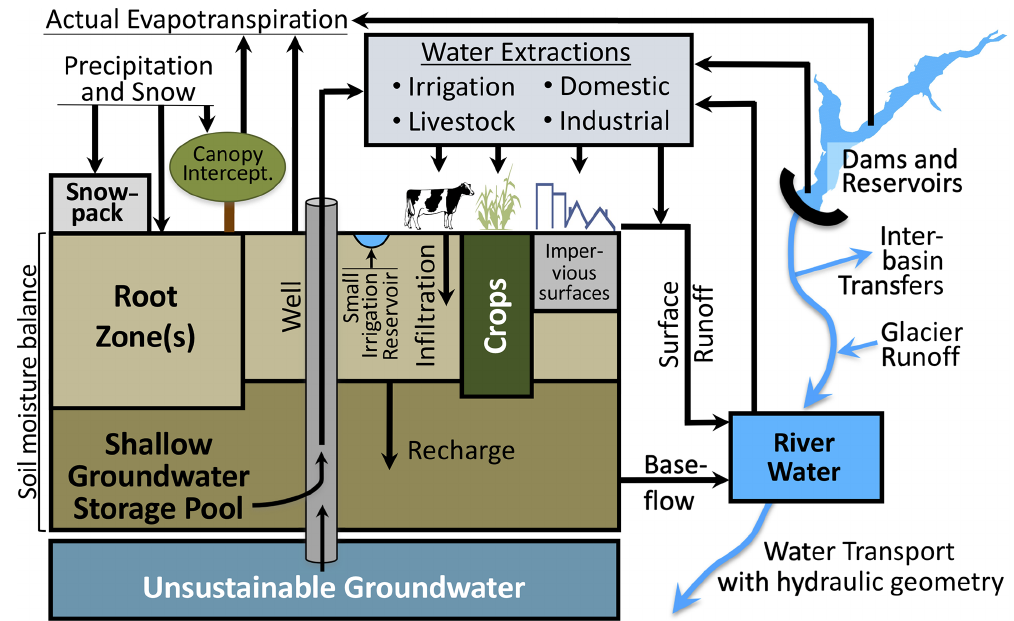
Figure 1. Schematic representation of the water balance model (WBM) showing major fluxes and storages, which are described in Sect. 2.2.1–2.2.6 below. The land surface fluxes are described in Sect. 2.2.1, and are: precipitation and snow, canopy interception, open water, runoff from impervious surfaces, soil moisture balance, actual evapotranspiration, surface runoff, and glacier runoff. Both the shallow groundwater storage pool and the unsustainable groundwater are described in Sect. 2.2.2. River water, including baseflow and hydraulic geometry, is described in Sect. 2.2.3. Section 2.2.4 describes dams and reservoirs, inter-basin transfers, and small irrigation reservoirs. All water extractions are described in Sect. 2.2.5. The model operates on daily time steps and over grid cells defined by the digital river network. Grid-cell resolutions have been used in the range from 30arcmin to